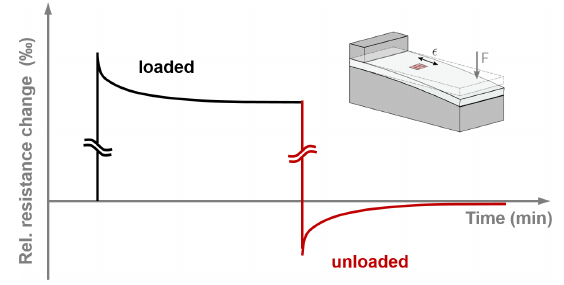
Figure 1. Scheme of measurement and resistance change during loading and unloading